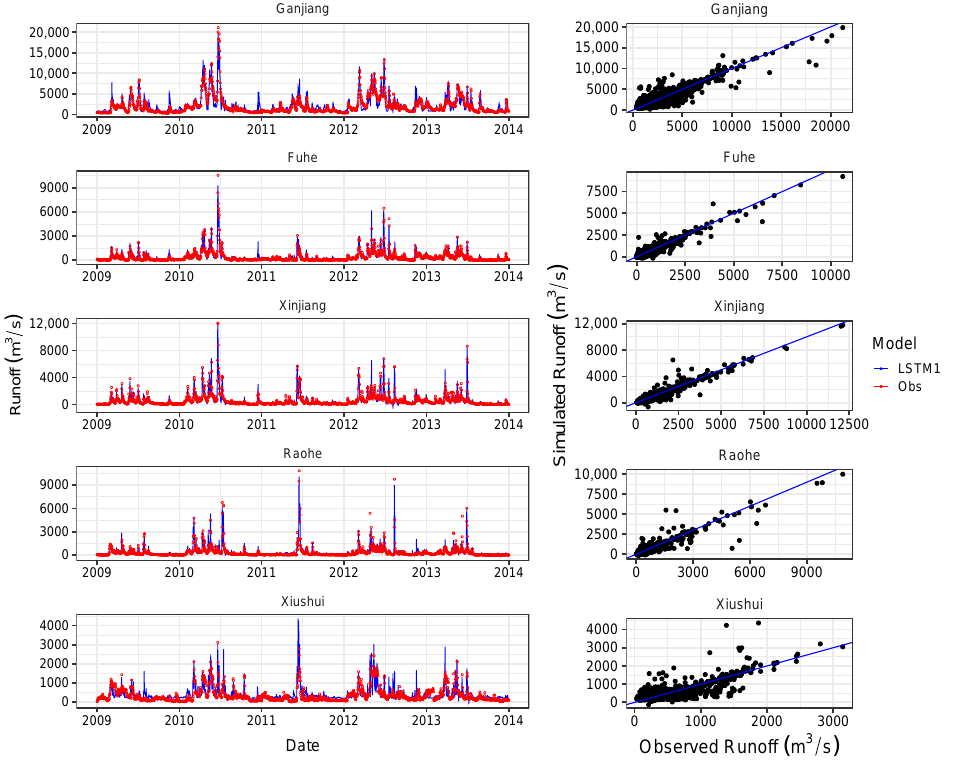
Figure 7. Performance of LSTM 1 during the validation period for all five sub-basins.